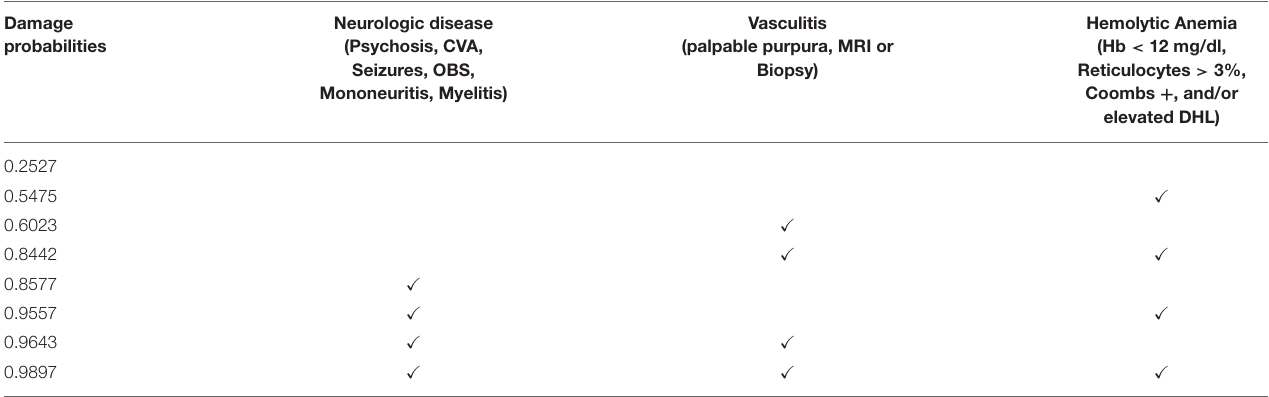
TABLE 4 | Clinimetric assessment of Damage (SDI ≥ 2). Damage